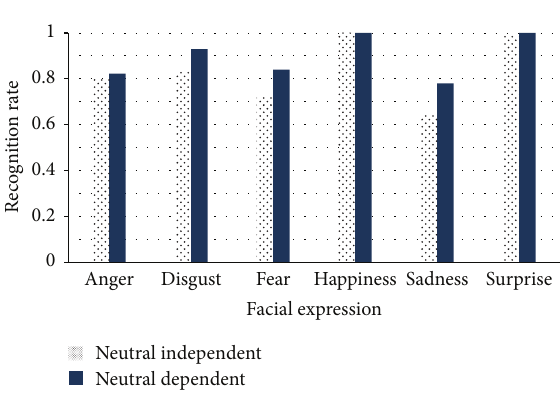
Figure 4: Recognition rate of human facial expression for CK+ database. In the neutral-dependent case, each feature is normalized to its corresponding value at the neutral expression of the same person. The results are obtained with the help of SVM